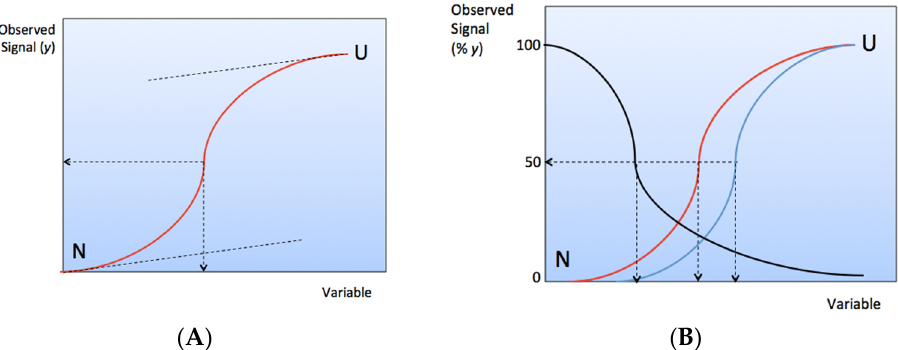
Figure 3. ( A ) Schematic diagram of reversible protein unfolding transition. At the transition midpoint [ N ] = [ U ] and K U = 1. ( B ) Multistep unfolding transition of an enzyme. Loss of enzyme activity (black curve) takes place first. Then, as the intensity of the perturbing variable is increased, buried thiol groups (cysteine residues) may become exposed to solvent (red curve), and thiol groups may react with chromogenic reagents such as dithiobisnitrobenzoic acid (DTNB). At higher variable intensity, where more extended conformational changes occur, tryptophan residues emerge on the protein surface and can be detected by the change in protein fluorescence (blue curve). Secondary structure changes can be observed at higher variable intensity by means of Raman and FT-IR